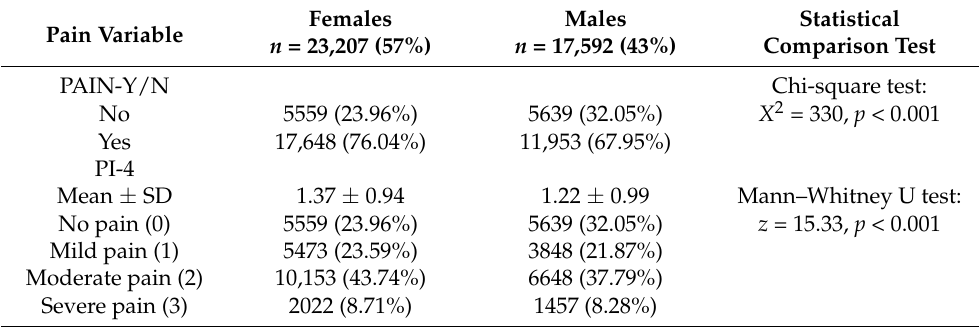
Table 4. Comparisons for dichotomous pain (PAIN-Y/N) and four-point pain scale (PI-4) between males and females without hypertension (controls, n =